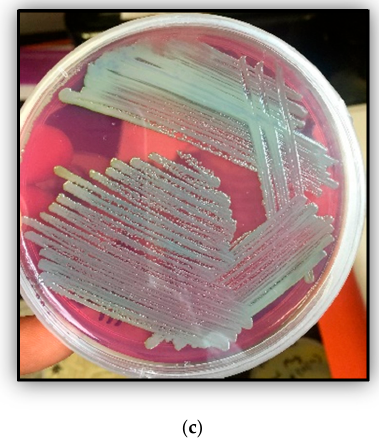
Figure 1. Shown are ( a ) growth experiments to determine the resistance abilities of Arthrobacter sp. strain SRS-W-1-2016 to Uranium (U) and Nickel (Ni), respectively. Growth of strain is shown in 4M media without amendments, as well as supplemented with 500 μ M U, 1000 μ M Ni and, and in the combination of 500 μ M U and 1000 μ M Ni, respectively; ( b ) shown are the measured concentrations of U and Ni over a three-day period that were spiked in microcosms containing strain SRS-W-1-2016; ( c ) histochemical plate-based growth assay to show phosphatase enzyme-based U-precipitation potential of strain SRS-W-1-2016. Bacteria that display a phosphatase-positive phenotype appear bright green on Tryptose Phosphate Methyl GreenTPMG agar plate.